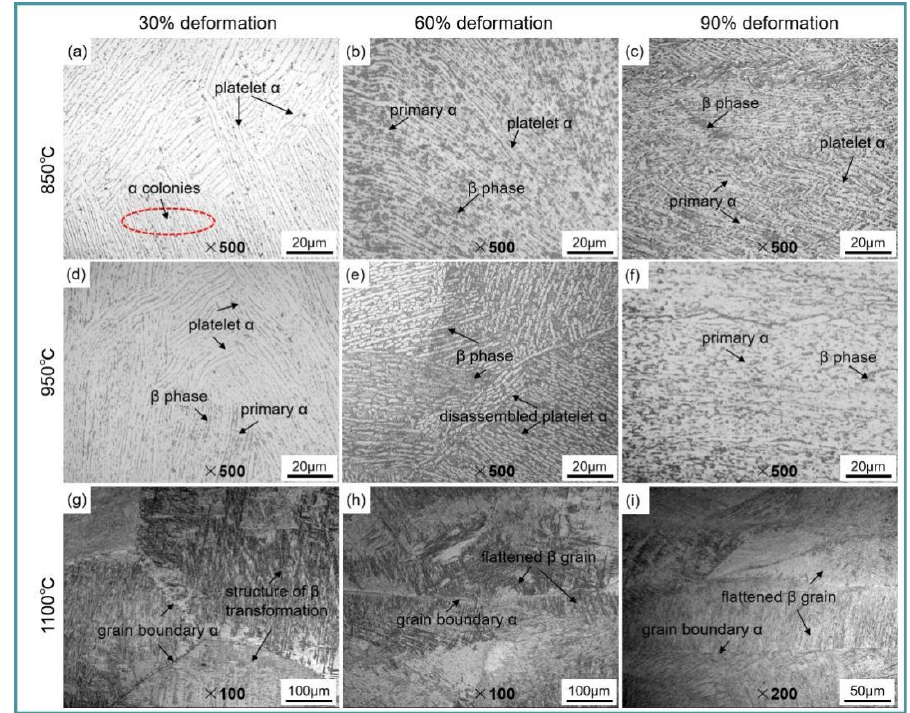
Figure 5. OM microstructure of Ti-6Al-4V alloy at different rolling temperatures and deformations: ( a – c ) Deformation 30%, 60% and 90% respectively at 850 °C, ( d – f ) Deformation 30%, 60% and 90% respectively at 950 °C, ( g – i ) Deformation 30%, 60% and 90% respectively at 1100 °C.